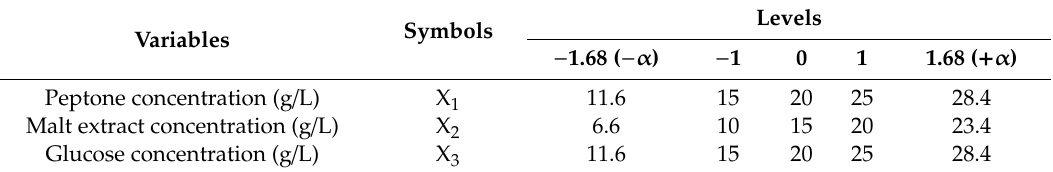
Table 1. Coded values of the variables for the central composite